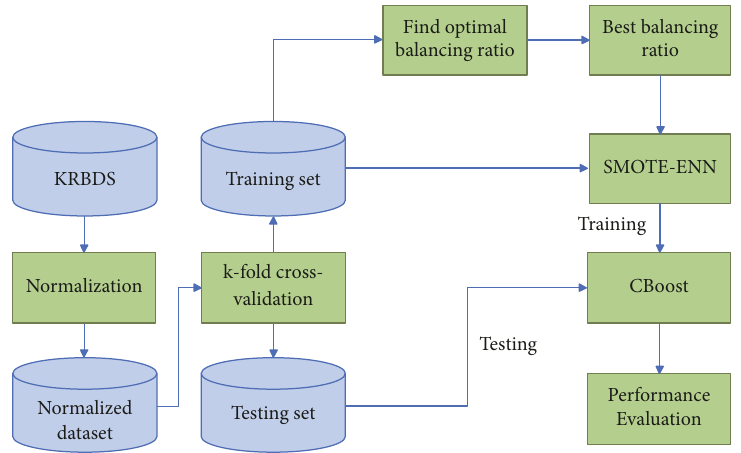
Figure 6: The flowchart of